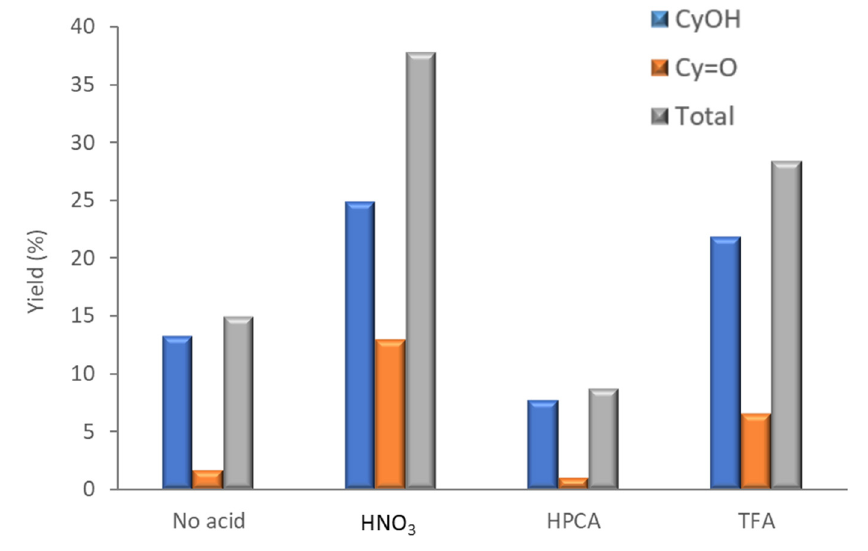
Figure 3. E ff ects of di ff erent additives on the oxidation of cyclohexane catalyzed by 1 . Reaction conditions: CyH (5 mmol); 1 (10 µ mol); TBHP (70% aq.) (10 mmol); NCMe (3 mL); 50 ◦ C; 3 h; under MW-irradiation (5